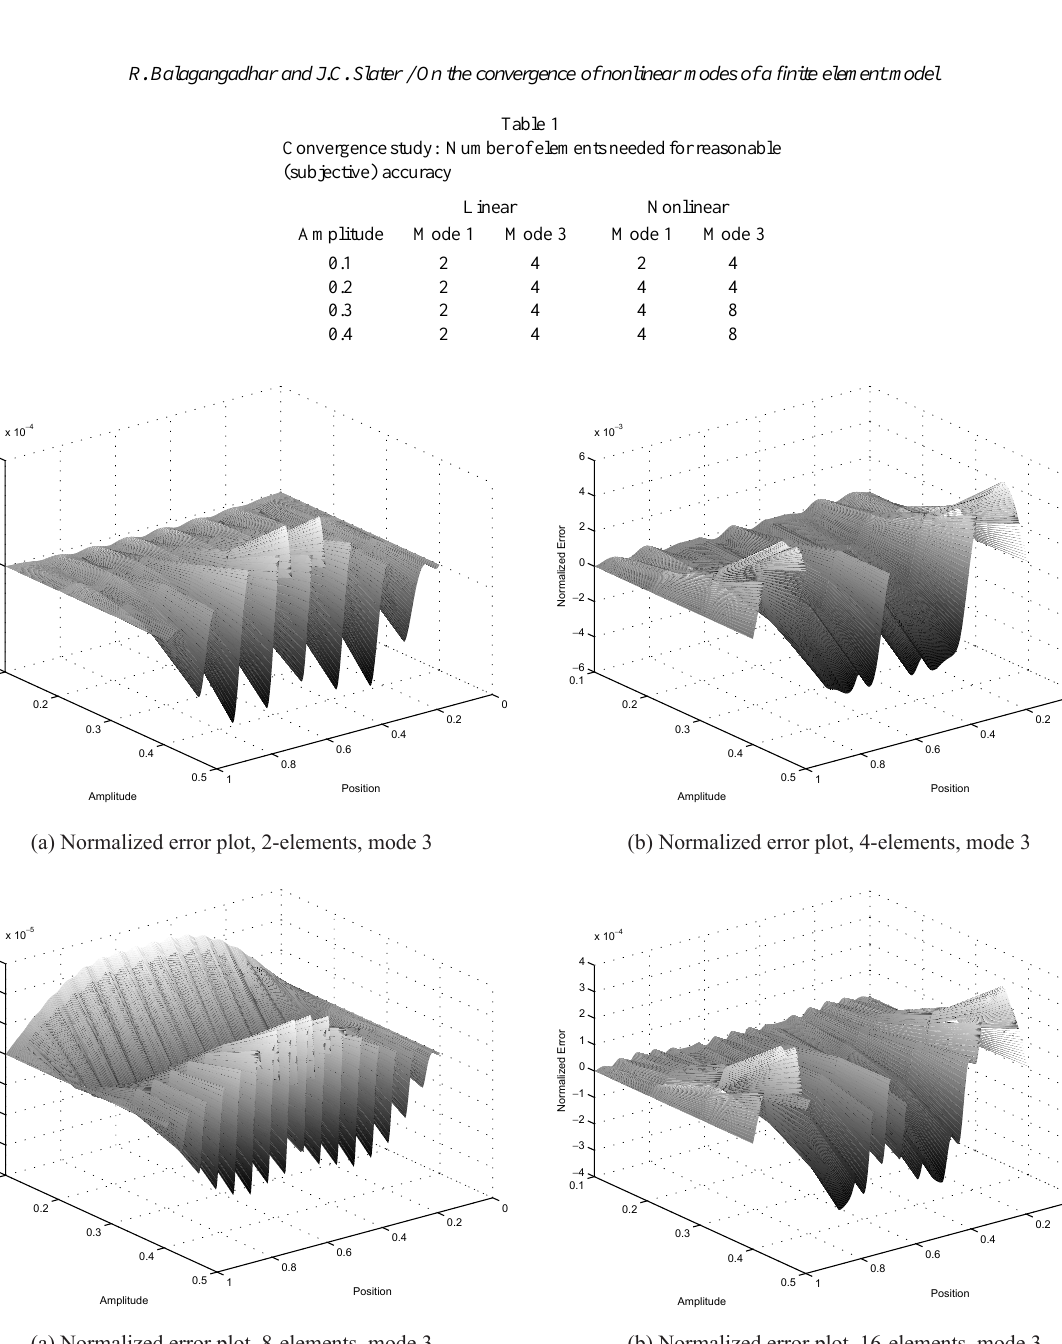
Fig. 4. Normalized errors in mode